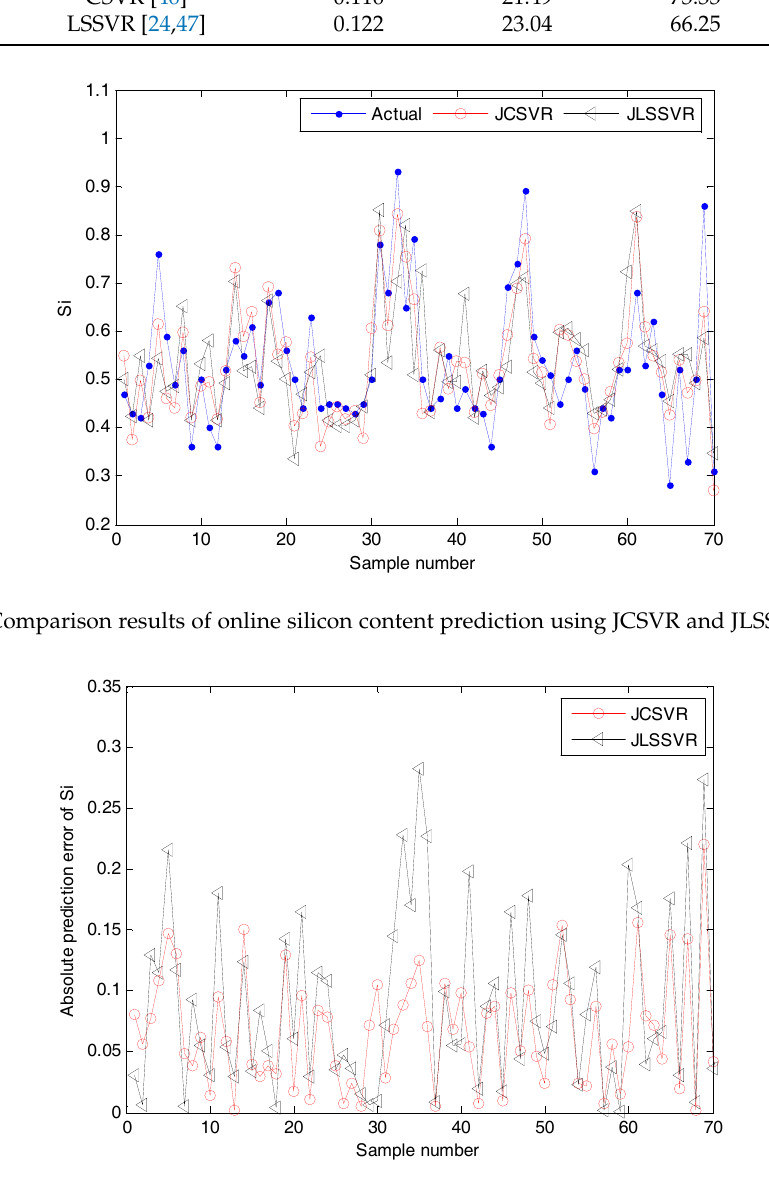
Figure 6. Comparison results of online silicon content prediction error using JCSVR and JLSSVR models (test set).